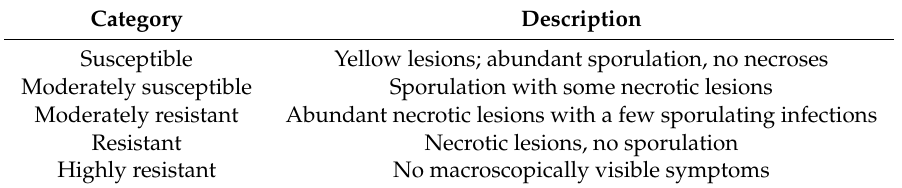
Table 9. Categories of resistance of daylilies ( Hemerocallis spp.) to rust ( Puccinia hemerocallidis ) according to (and adapted from) Li et al.